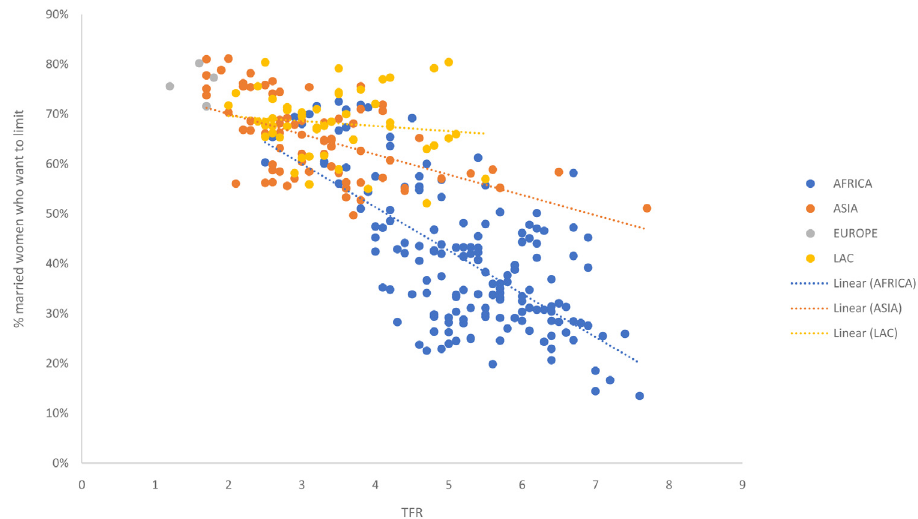
Figure 2. Relationship between TFR and share of married women who want no more children (limiters). The dots in the scatterplot represent survey data from all available Demographic and Health Surveys (DHS), color coded by region. The data shows the relationship between the total fertility rate (TFR) and the share of married women want no more children (limiters).